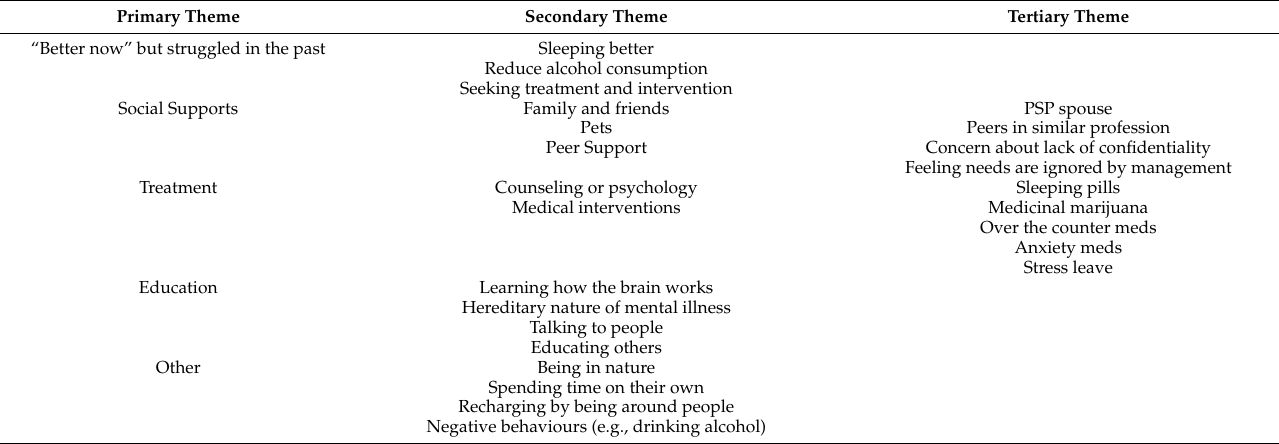
Table 2. Primary, secondary, and tertiary coding